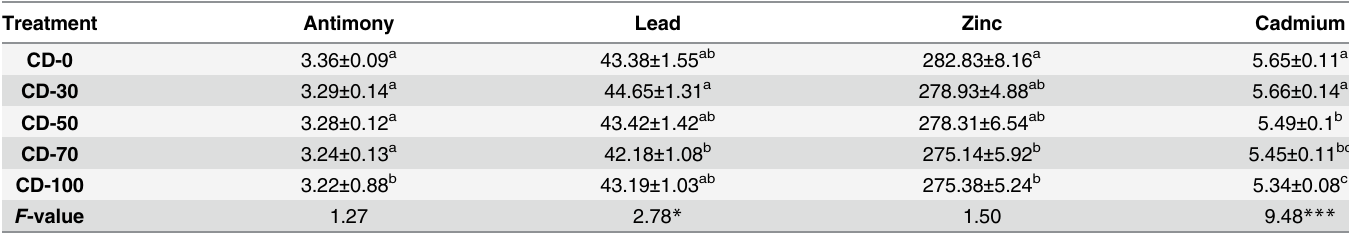
Table 5. Contents of heavy metals of sewage sludge and cattle dung manure in the different treatments (mg/kg).